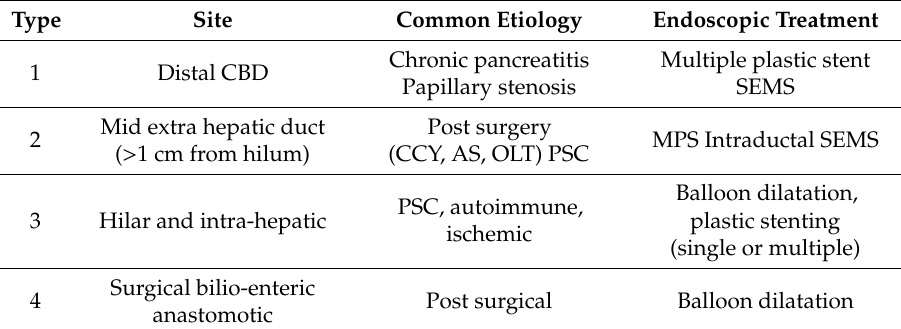
Table 1. Treatment modality according to stricture location and